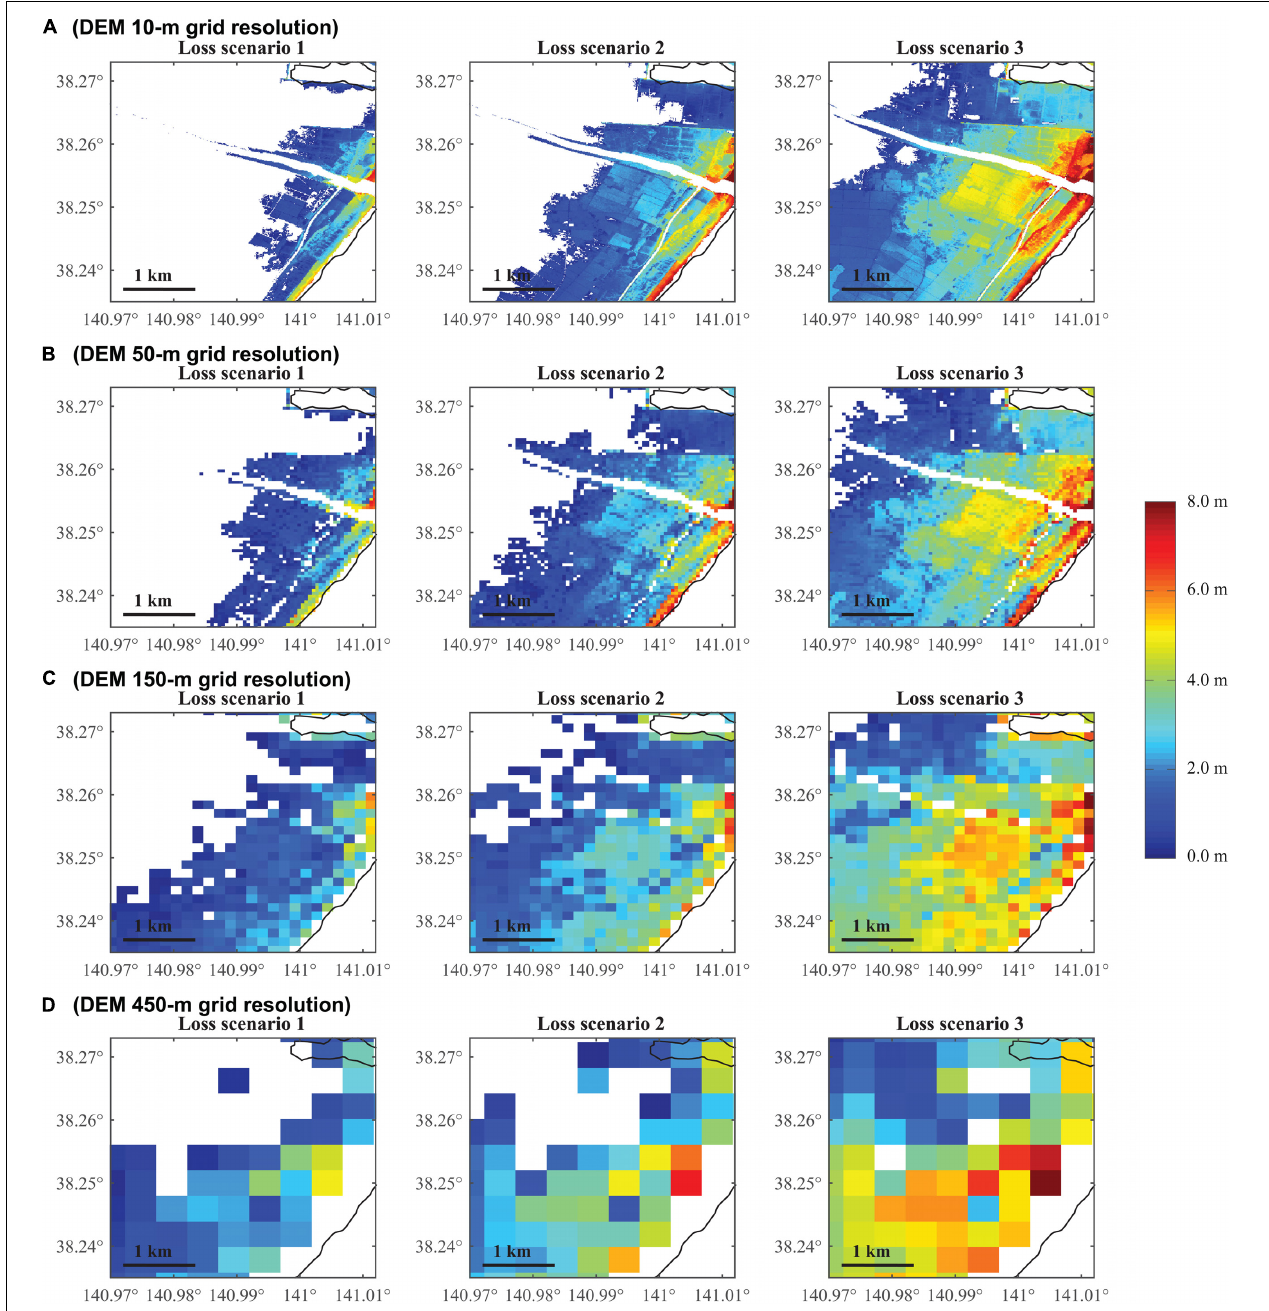
FIGURE 6 | Inundation depth maps of M w 9.0 events for region PR1 in Sendai by considering different DEM resolutions: (A) 10-m, (B) 50-m, (C) 150-m, and (D) 450-m.